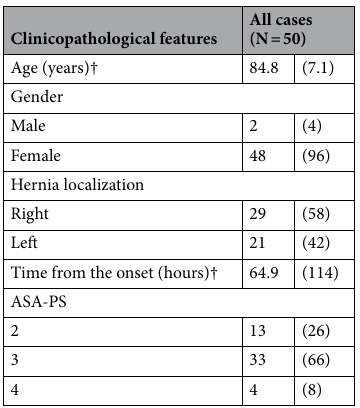
Table 1. Patient characteristics. Values in parentheses are percentages unless indicated otherwise † values are mean (SD).